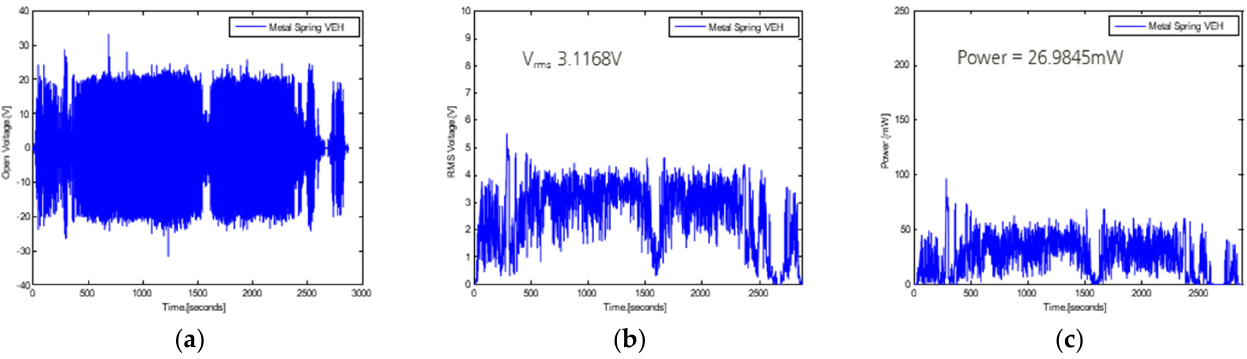
Figure 14. Performance test results of the metal vibration ‐ energy ‐ harvesting (VEH) device with a mechanical stopper, a 45 ‐ Hz resonance frequency, and a 360 ‐Ω load resistance: ( a ) peak ‐ to ‐ peak voltage (V pk ‐ pk ‐ veh ‐ T ); ( b ) root mean square (RMS) generated voltages (V rms ‐ veh ‐ T ); ( c ) experimentally generated power (P exp ‐ veh ‐ T ).